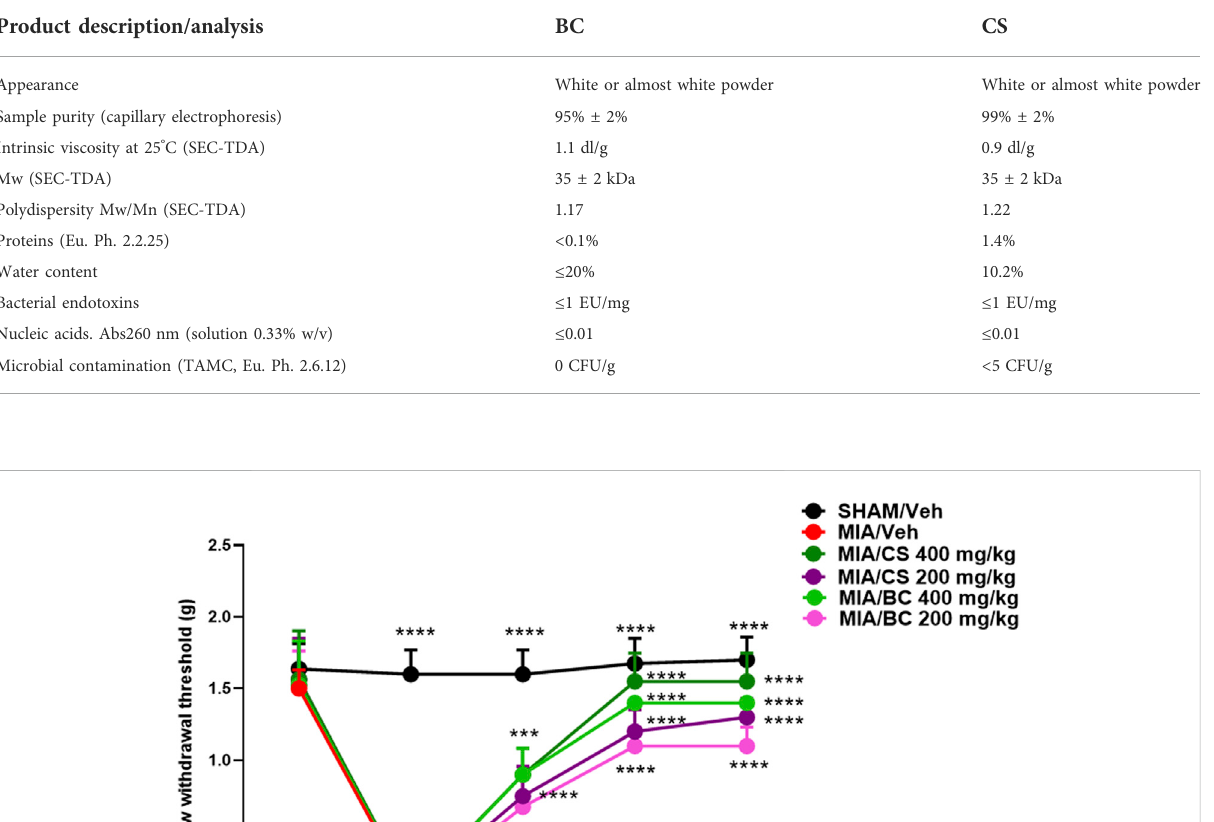
TABLE 1 Complete characterization of BC and CS.